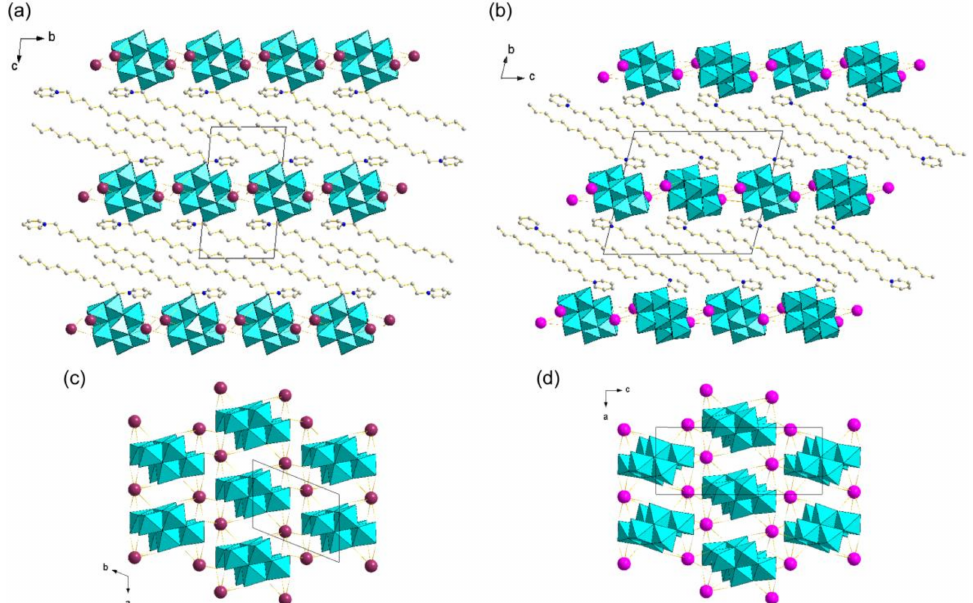
Figure 4. Crystal structures of C 12 py-Rb-Mo 8 and C 12 py-Cs-Mo 8 (C: gray, N: blue, Rb: plum, Cs: pink; β -Mo 8 in blue polyhedrons). H atoms and disordered atoms are omitted for clarity: ( a ) Packing diagram of C 12 py-Rb-Mo 8 along the a axis; ( b ) Packing diagram of C 12 py-Cs-Mo 8 along the a axis; ( c ) Molecular arrangements of C 12 py-Rb-Mo 8 in the inorganic layers ( ab plane); ( d ) Molecular arrangements of C 12 py-Cs-Mo 8 in the inorganic layers ( ac